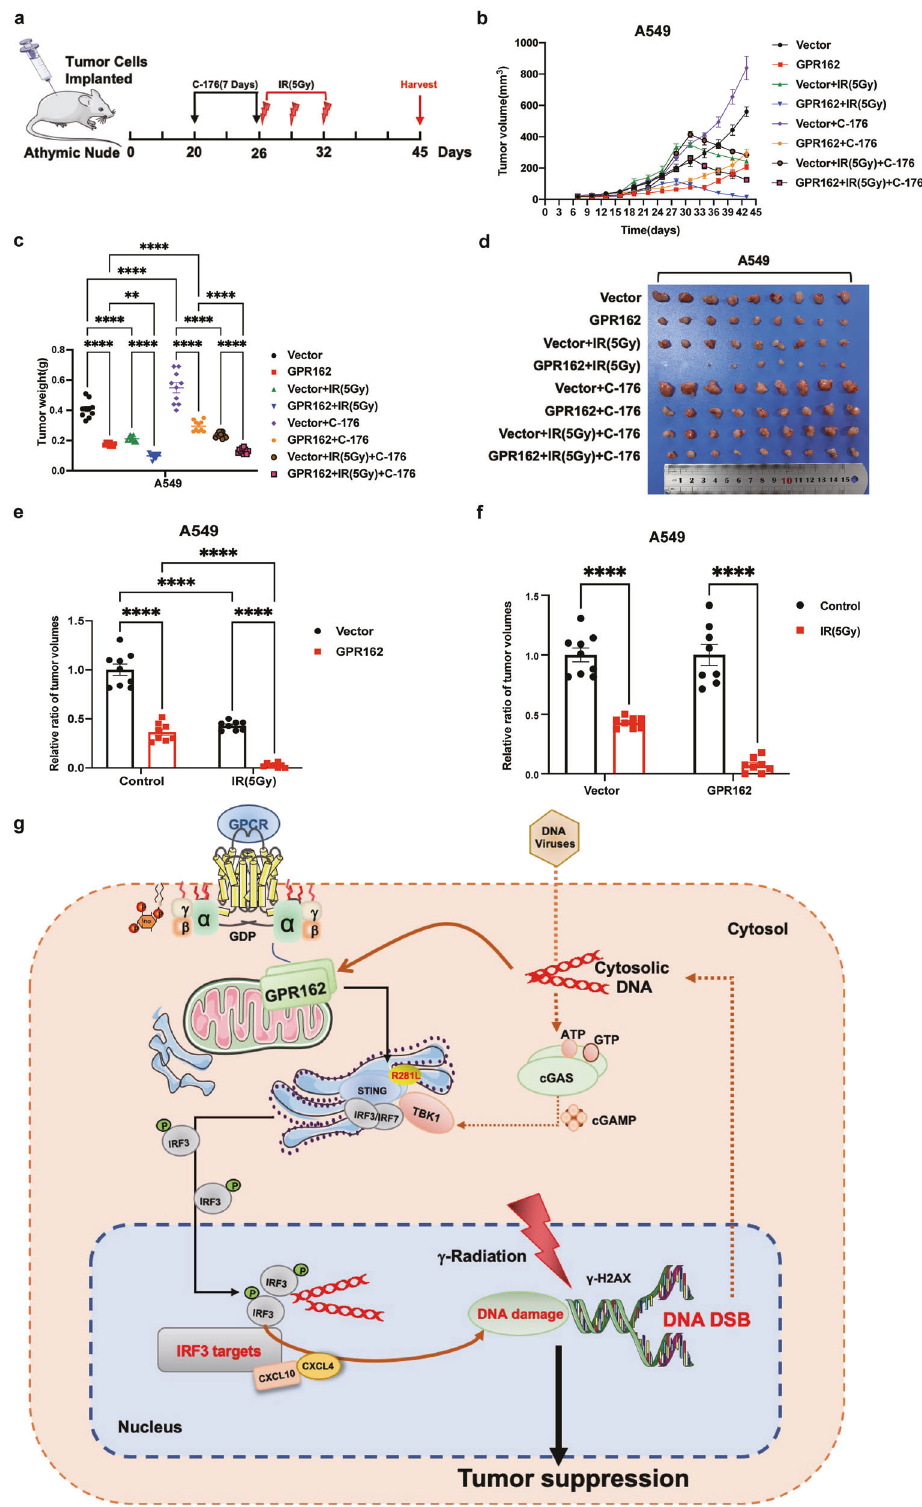
Fig. 8 GPR162 increases the anticancer impact of radioimmunotherapy by stimulating the STING signaling pathway. a Treatment schedule of IR and C-176. b – d Subcutaneous tumors of A549 cells respond to the speci fi ed therapies. Each group has ten mice. Tumor formation was tracked at the times indicated ( b ), weight ( c ), and pictures ( d ) are shown. e , f The tumor volume of the control group and the overexpression group. g Schematic model of radio-induced GPR162-STING-DNA damage in cancer: GPR162, a novel tumor suppressor, can promote the DNA damage response induced by radiotherapy to activate STING, and further activate STING to induce DNA damage of tumor cells and inhibit the occurrence and development of tumors